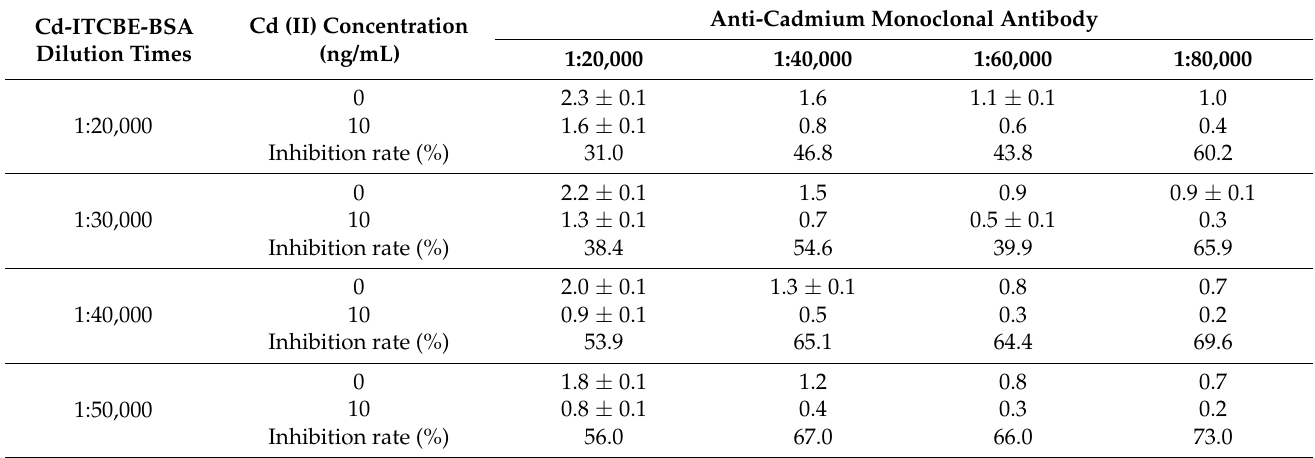
Table 1. The optimum concentration of anti-cadmium monoclonal antibodies and Cd-ITCBE-BSA. Cd (II) Cd-ITCBE-BSA Dilution Times